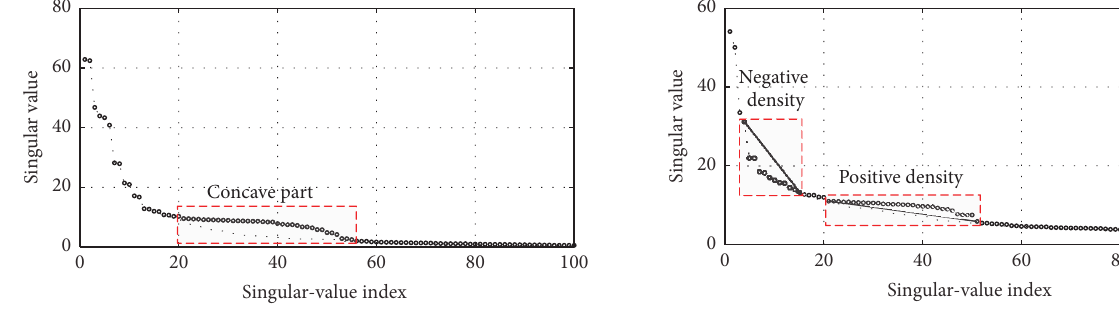
Figure 12: Examples of regions with negative and positive concavity density.